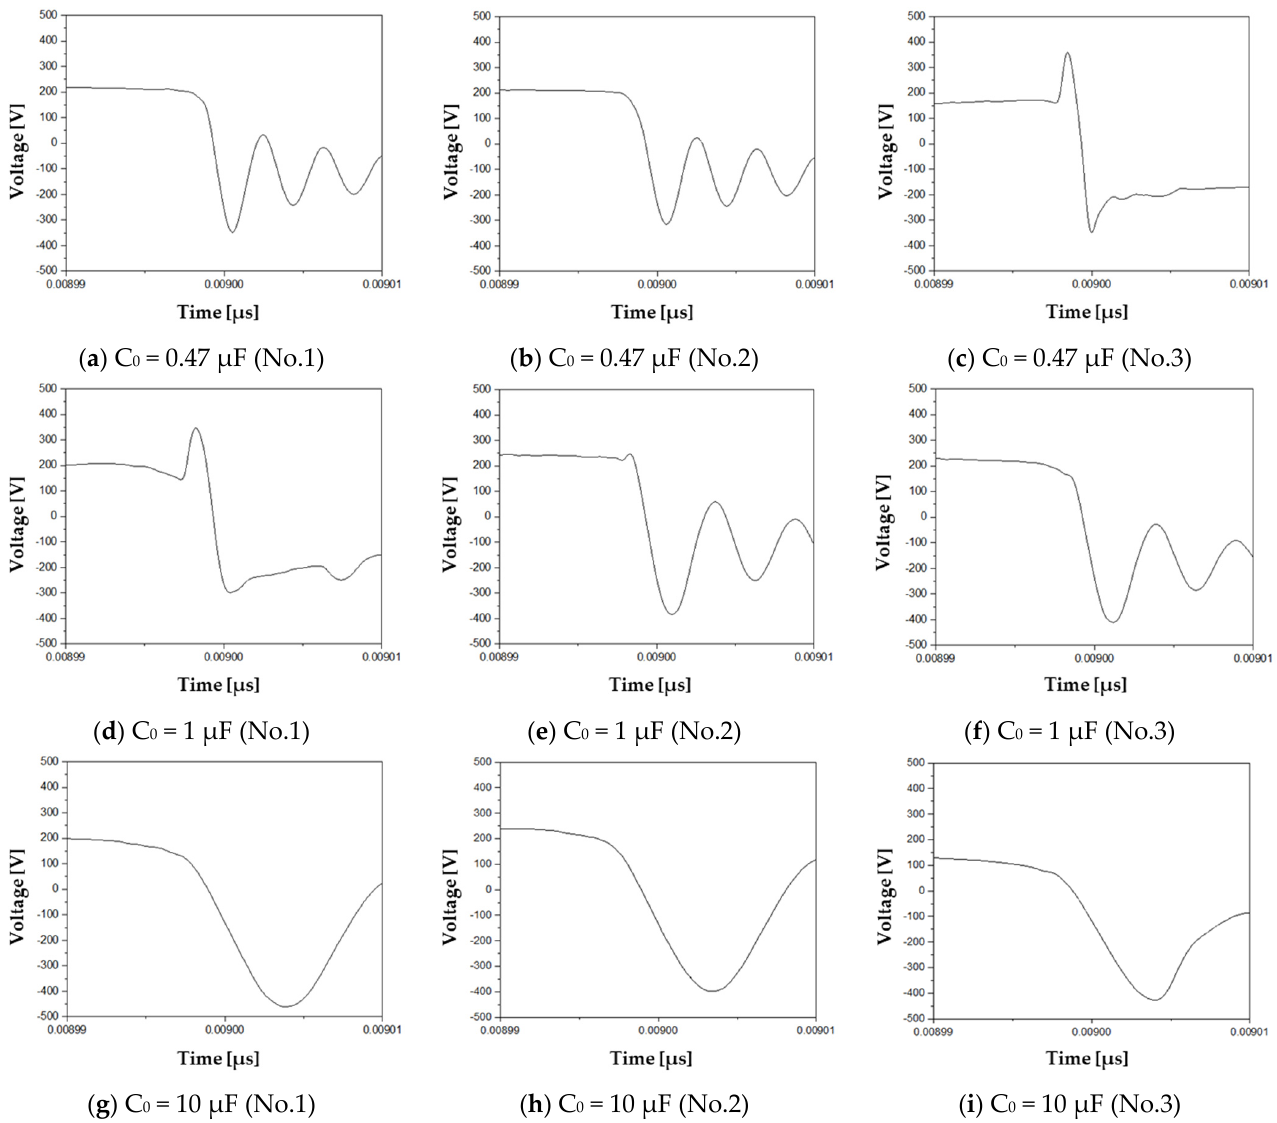
Figure 16. Dielectric recovery voltage under disturbing magnetic fields.